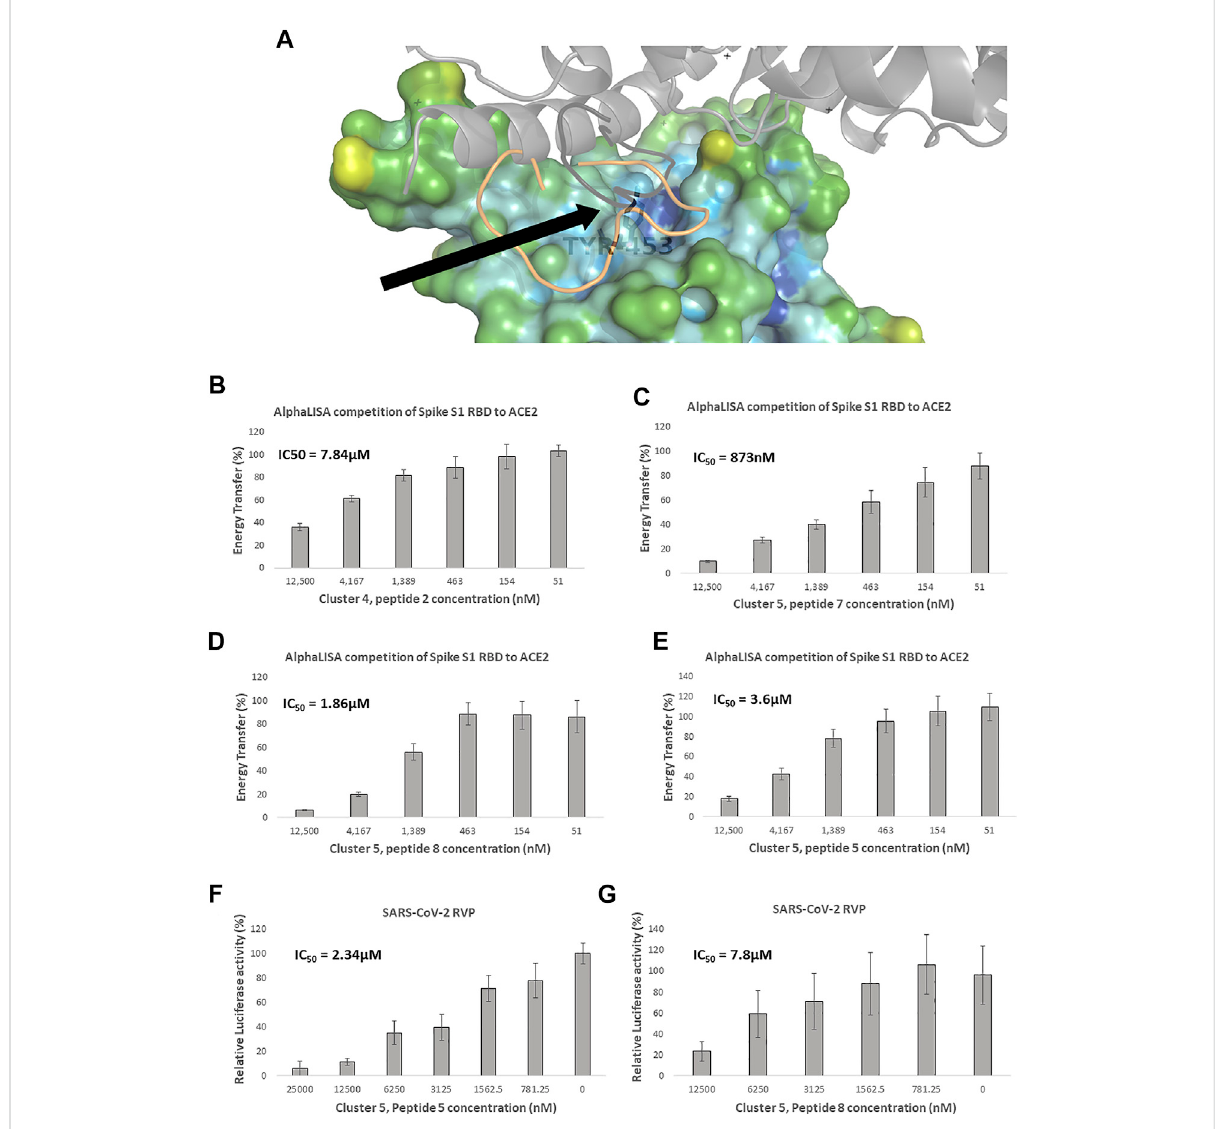
FIGURE 3 Competitive spike RBD targeted screening. (A) A heat diagram analysis of RBD surface concavity (PDB: 6VW1, chain E), (blue = concave, red = convex), the ACE2 receptor is shown as a grey cartoon. Tyrosine 453, chosen as the center of the screening grid, is shown with the black arrow. Cluster 4, peptide 7 docking model is shown as orange cartoon and Cluster 4, peptide 7 in black cartoon. AlphaLISA analysis was used to detect the interaction between the spike protein and the hACE2 receptor. Characterization of inhibitory effect on the interaction between spike and hACE2 proteins. IC 50 was calculated for (B) Cluster 4, peptide 2 and (C) Cluster 5, peptide 7 (D) Cluster 5, peptide 8 and (E) Cluster 5, peptide 5 ( n = 2 biological replicates, 3 technical replicates per experiment, standard mean error (SEM) is represented for each concentration) Of these macrocycles, only (F) Cluster 5, peptide 5 n = 3 (9 technical replicates) and (G) Cluster 5, peptide 8 n = 3 (9 technical replicates), showed speci fi c SARS-CoV-2 RVP inhibition. SARS-CoV-2 and control lentivirus were incubated with the tested peptide and cells stably expressing human ACE2